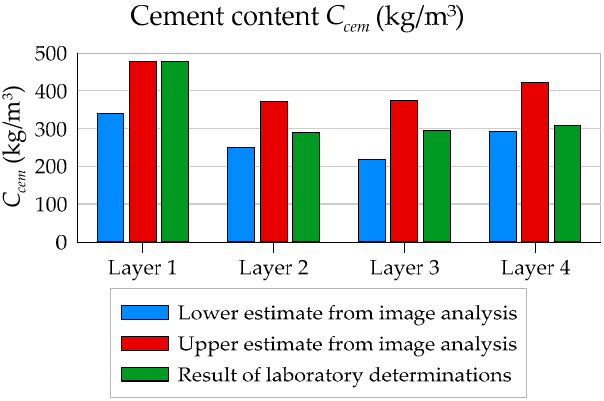
Figure 20. Estimation of cement content C cem (kg/m 3 ) in particular layers of the element’s wall.